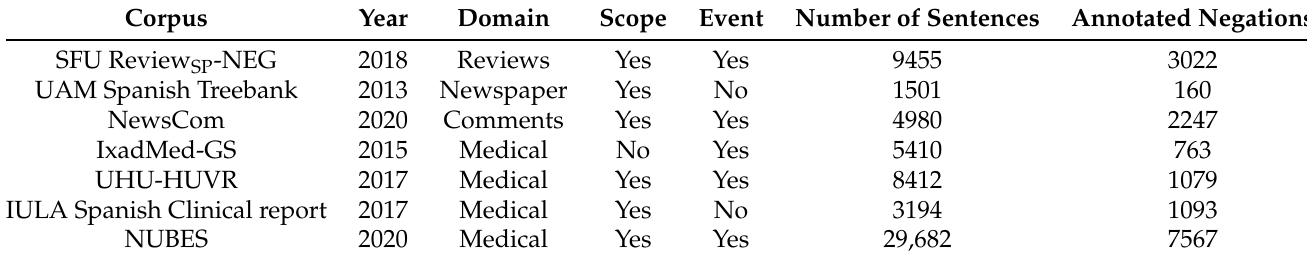
Table 2. Spanish corpora annotated with